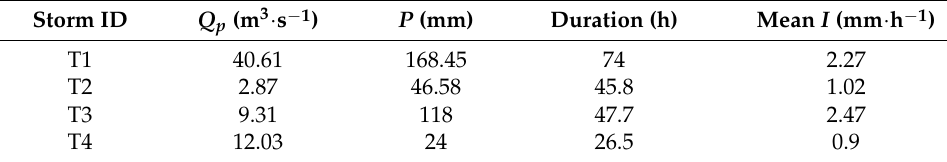
Table 2. Characteristics of the storms studied.